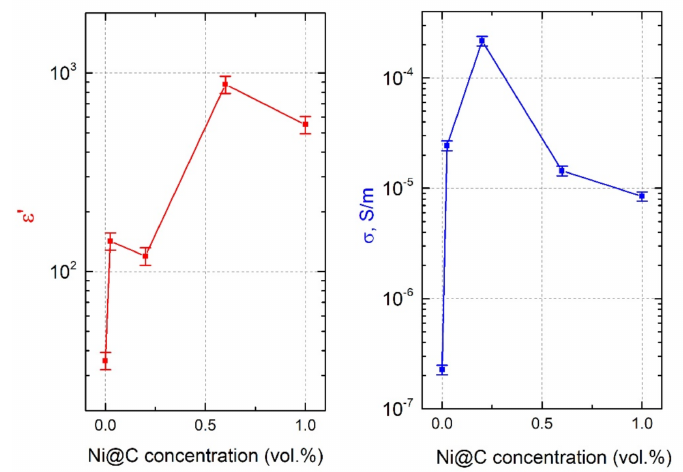
Figure 12. Ni@C-concentration dependencies of the dielectric permittivity and the electrical conduc- tivity for composites with fixed MWCNTs content of 0.09 vol.% at room temperature and frequency of 129